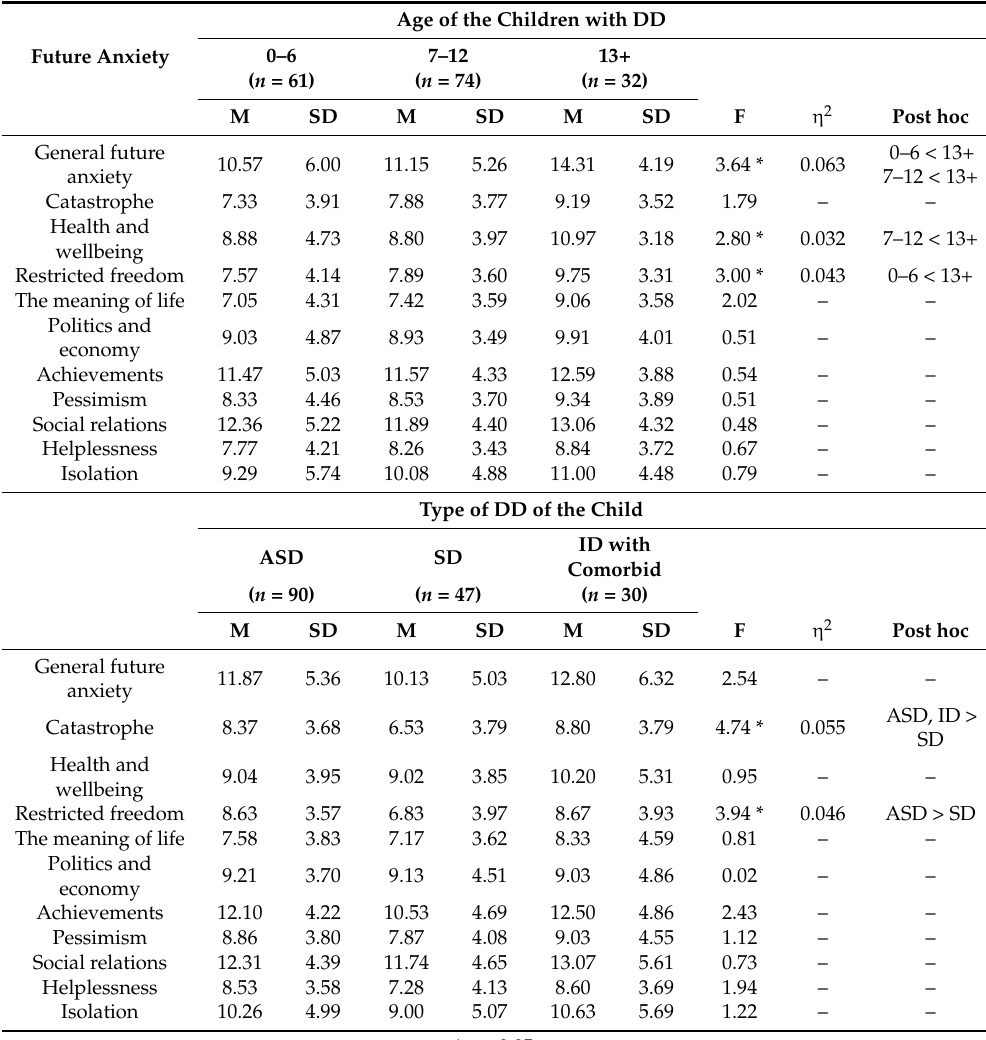
Table 5. Means, standard deviations, F-statistics, and effect sizes for ANCOVA of age of the children with DD and ANOVA of type of DD of the